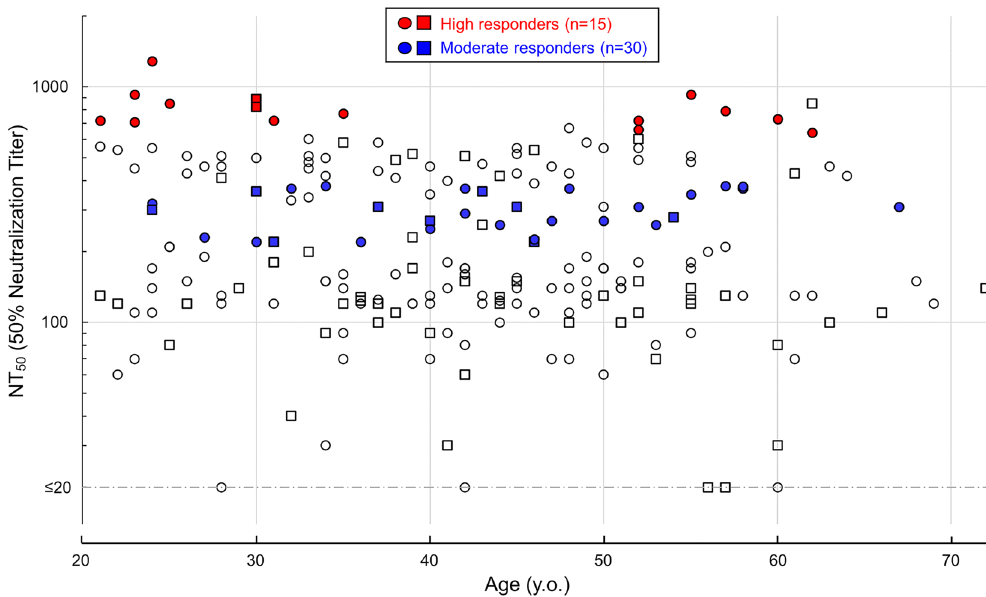
Figure 1. Neutralization of wild-type SARS-CoV-2 05-2N by day-60 sera. Neutralization activity of day-60 sera obtained from participant were shown. Day-60 participants whose sera showed NT 50 values against SARS-CoV- 2 05-2N greater than 500-fold were classified as high responders (open red circles, n = 15), and participants whose sera showed NT 50 values around average of all participants (range 220 to 380-fold) were categorized as moderate responders (open blue circles, n =